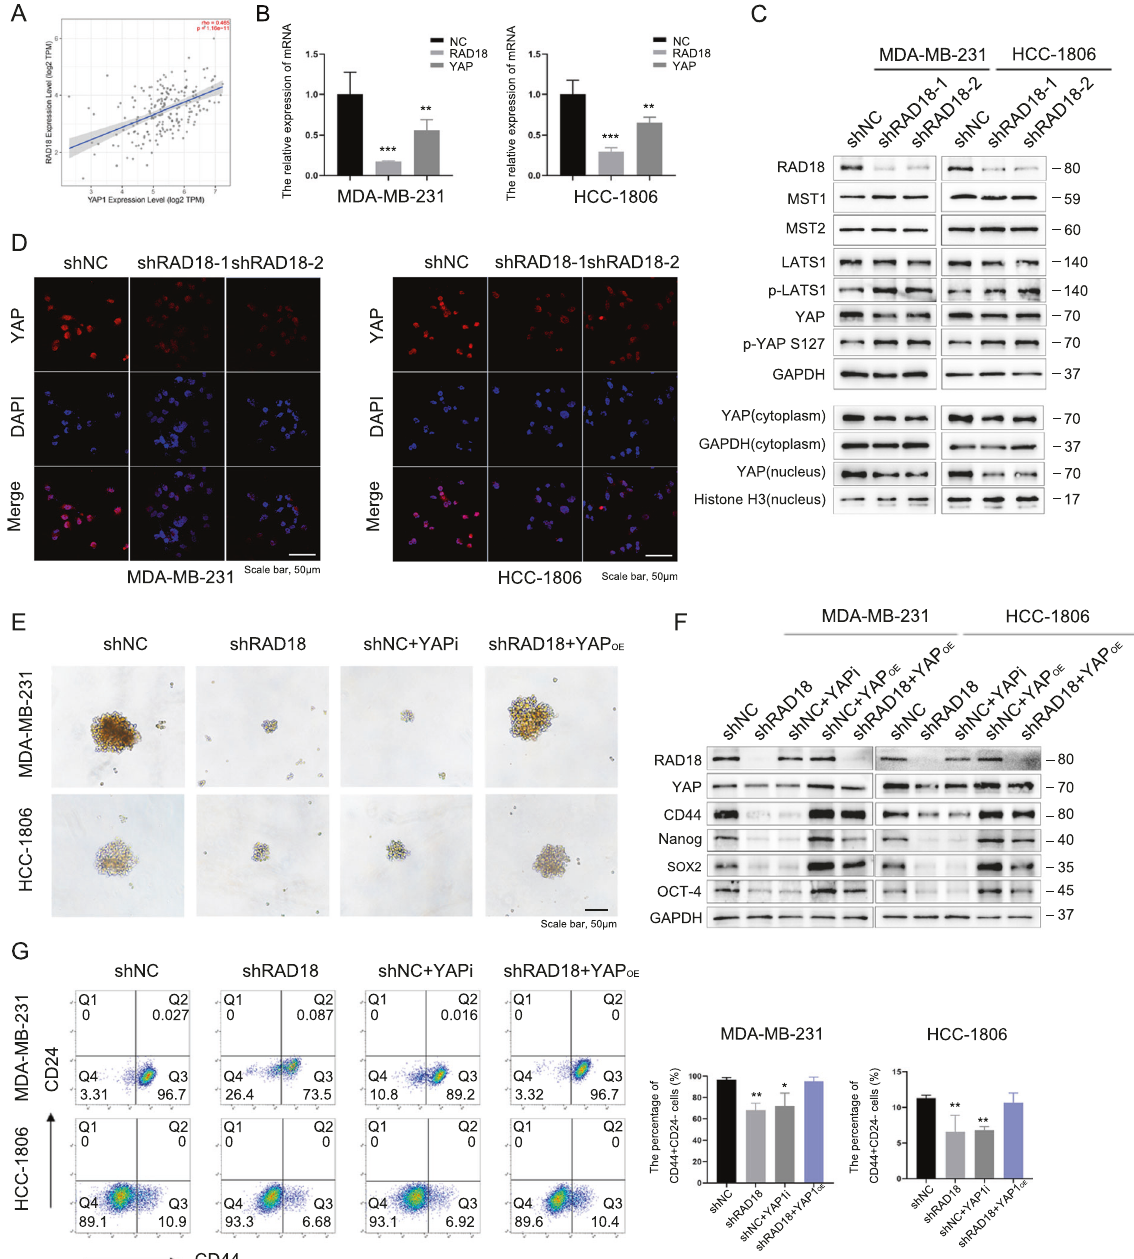
Fig. 3 RAD18-induced stemness in TNBC are mediated by Hippo-YAP pathway. RAD18 enhances TNBC cell stemness through the Hippo- YAP pathway. A RAD18 was signi fi cantly positive correlated with YAP in TNBC according to Timer software (rho = 0.465, p = 1.16e-11). B Knockdown of RAD18 reduced the mRNA level of YAP through qRT-PCR. C Western blot analysis of the expression levels of Hippo-YAP pathway proteins including MST1/2, LATS1, p-LATS1, p-YAP S127, YAP (in total, cytoplasm and nucleus) in shNC and shRAD18 TNBC cell lines. GAPDH levels served as a loading control. D Representative fl uorescence confocal microscopy images analyzing the YAP (red) expression in shNC and shRAD18 groups as indicated. Nuclei are stained with DAPI (blue). E – G The tumor sphere forming ( E ), stemness-related proteins levels ( F ), and CD44 + /CD24 − population percentages ( G ) in the shNC groups treated with vertepor fi n for 24 h and the shNC/shRAD18 groups treated with YAP overexpression plasmid were performed to determine cell stemness. * p < 0.05, ** p < 0.01, *** p < 0.001. All experiments were performed independently at least three